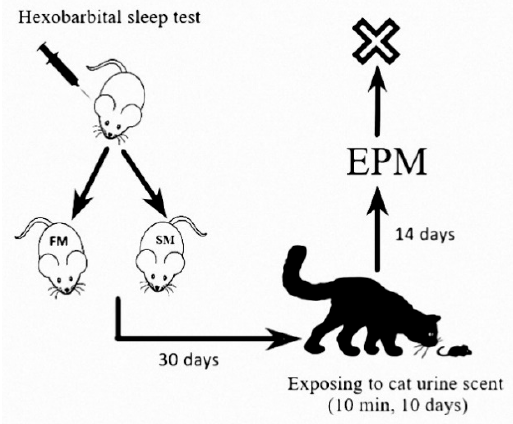
Figure 2. Experimental design. EPM — elevated plus maze test.